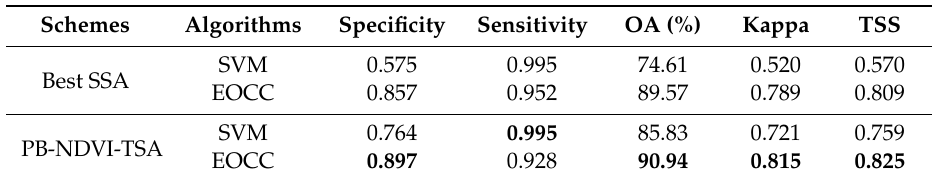
Table 7. Classification accuracies of the optimal SSA and the second phenology-based (PB) NDVI-TSA using the EOCC and SVM algorithms in the DMNNR. The best result of each accuracy metric for each scheme is